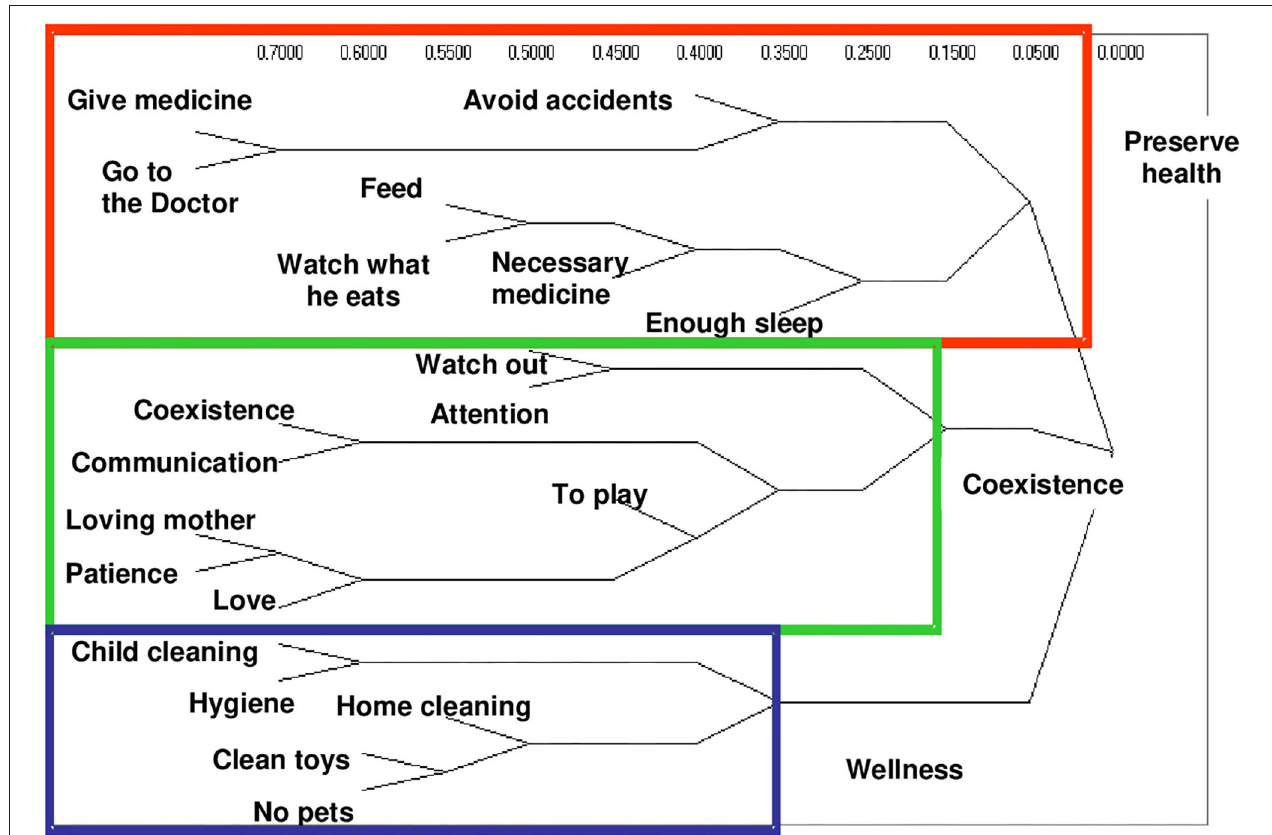
FIGURE 2 | Conceptual dimensions of child care by hierarchical conglomerates. Group 2. Caregivers of children hospitalized 6 months ago.